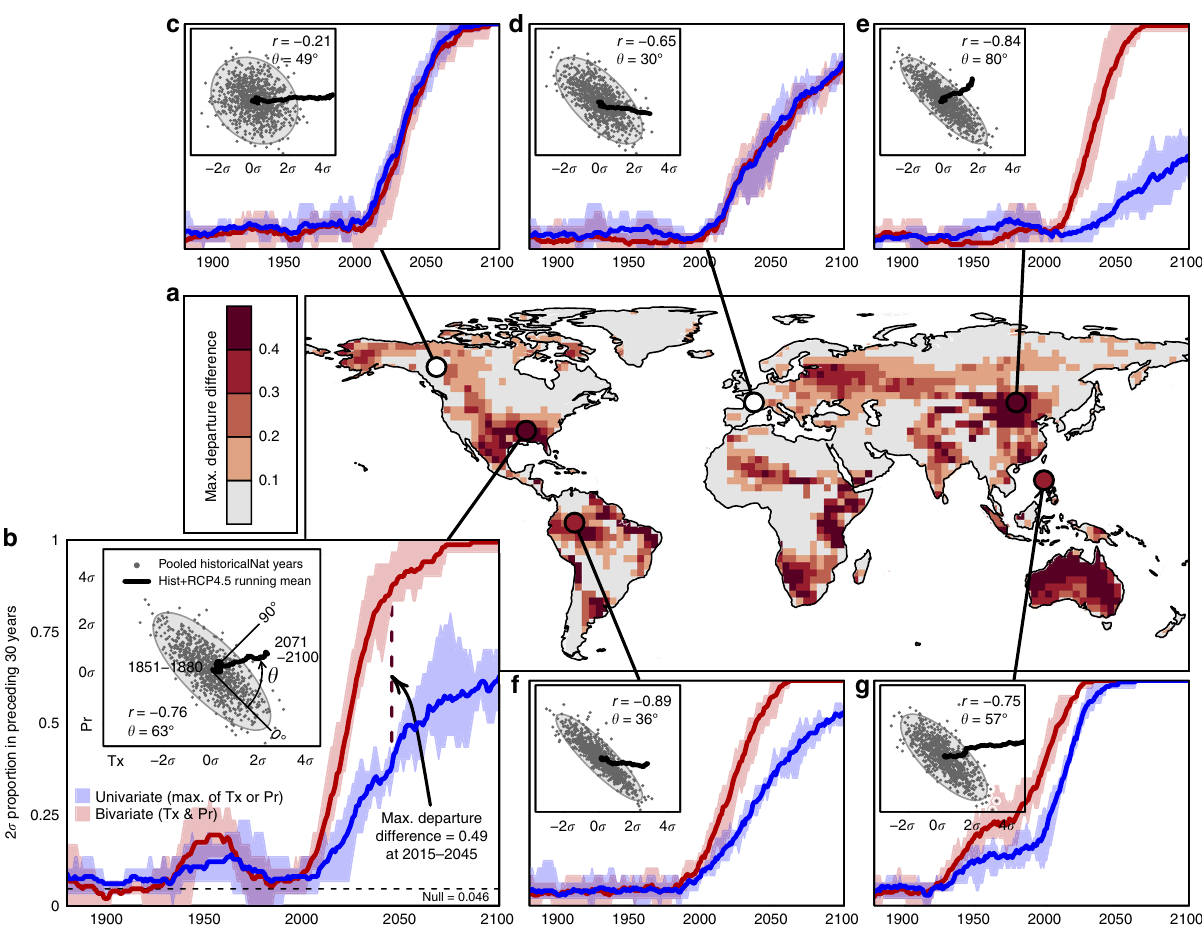
Fig. 2 Univariate and bivariate climate departures for summer precipitation and mean daily maximum temperature at selected locations; CanESM2 RCP4.5 ensemble projection. a Terrestrial regions where bivariate departures from natural variability exceed univariate departures, measured as maximum departure difference during the 1880 – 2100 period. b Time series of univariate and bivariate 2 σ proportions near Memphis, USA. Univariate values are the larger of the precipitation (Pr) and mean daily maximum temperature (Tx) 2 σ proportions. Bivariate proportions are assessed against the joint distribution of Tx and Pr. Shaded regions of the time series indicate the spread of the 5-run CanESM2 ensemble; solid lines are the ensemble mean. b (Inset) Scatterplot of CanESM2 historicalNat projections of Tx and Pr, pooled and normalized across fi ve runs of the 1850 – 2006 period. Correlation (Pearson ’ s r ) is measured using the normalized values of Tx and Pr. The orthogonality of climate change ( θ ) is the angular displacement of the bivariate climate change trajectory from the dominant axis of bivariate interannual variability. c – g Equivalent plots for c Whitehorse, Canada; d Central France; e Eastern Mongolia; f the Colombian Amazon; and g Manilla, Philippines. The dashed line in plot b indicates the expected 2 σ proportion of 0.046 in a stationary climate with Gaussian (normal)